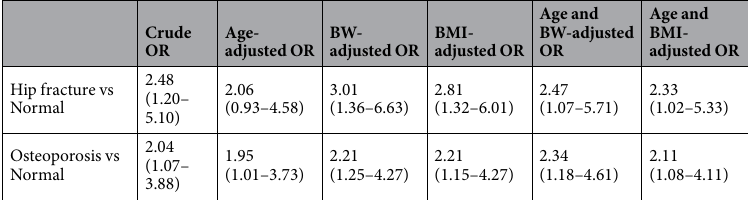
Table 3. ALDH2 rs671 genotype frequencies and odds ratios (OR) after adjustments.